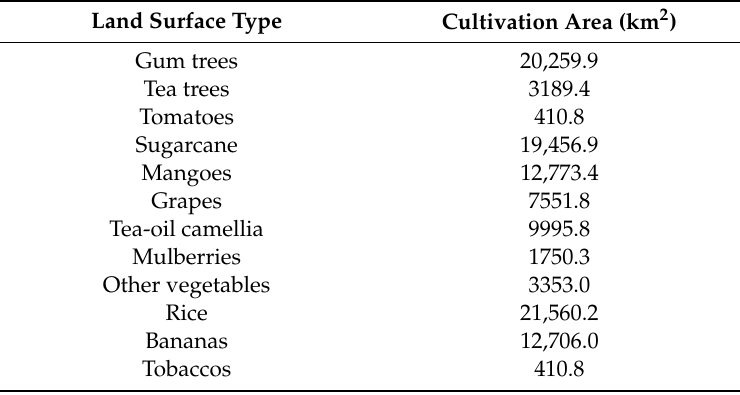
Figure 5. Crop-type map for Guangxi Zhuang Autonomous Region, China, with insets showing zoomed in samples for four major crop types—rice, sugarcane, gum tree, and mango. Table 2. Cultivation areas for all the crop